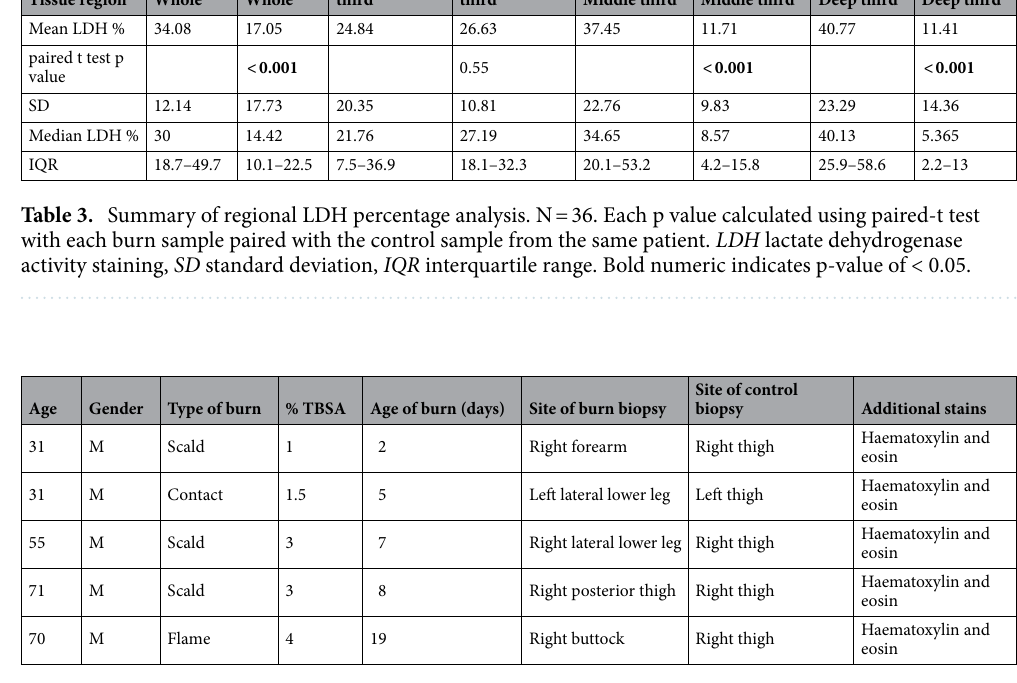
Table 4. Demographics of histological imaging patients undergoing haematoxylin and eosin (H&E) stain. The samples taken from these patients were immediately fixed in formalin before being embedded in paraffin.